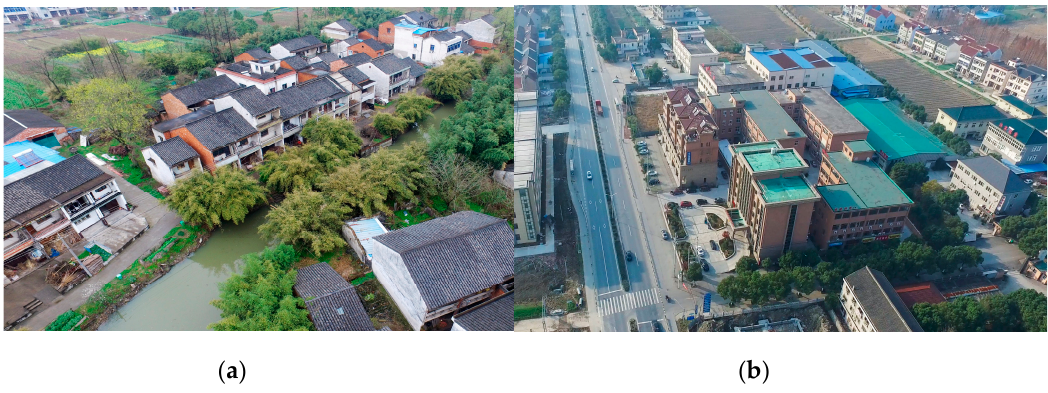
Figure 2. Image examples on the ground for different types of the impervious and previous surfaces in our study area, including typical examples in rural ( a ), and town areas ( b ).